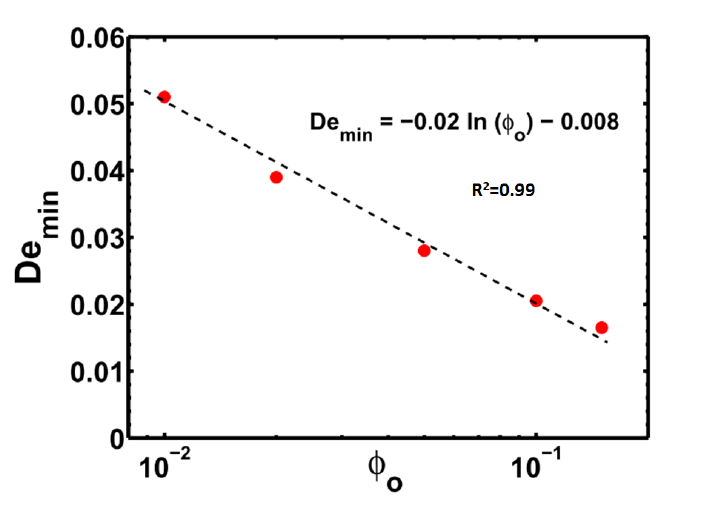
Figure 6. De min as a function of polymer concentration φ 0